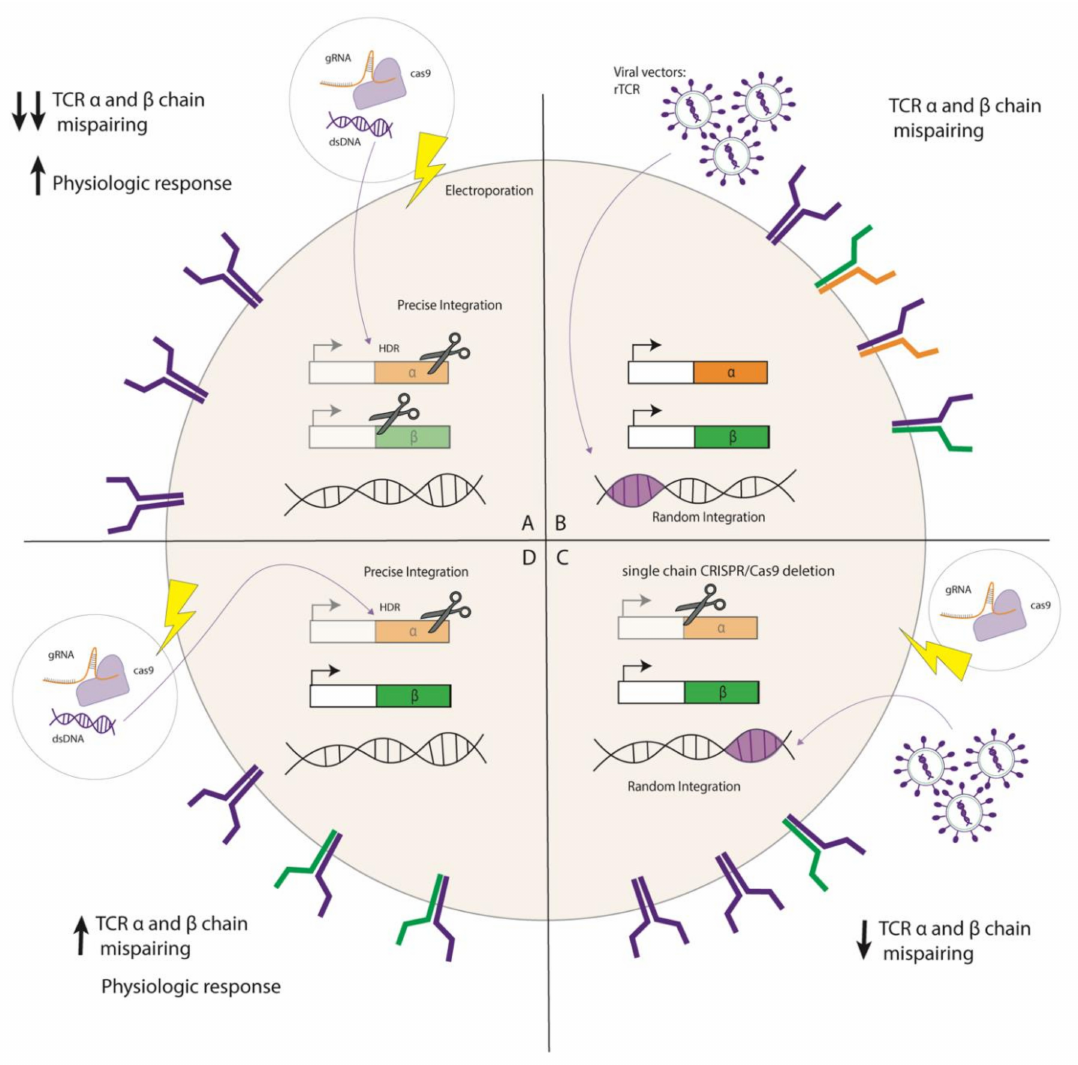
Figure 2. Options to combine gene-editing with rTCR gene augmentation, with precise or random integration. ( A ) Precise integration of rTCR in the TRAC locus with simultaneous disruption of TRBC locus decreases the possibility of TCR mispairing and is characterized by a physiological and endogenously controlled expression of the rTCR. KO only the TRAC locus when using random integration techniques decrease the chance of TCR molecule mispairing ( C ) compared to a not-gene editing approach ( B ). Notably knocking-in the rTCR into the TRAC locus increased the rate of TCR mispairing on the cell surface ( D ). (Schematic representation of data obtained by Schober et al.